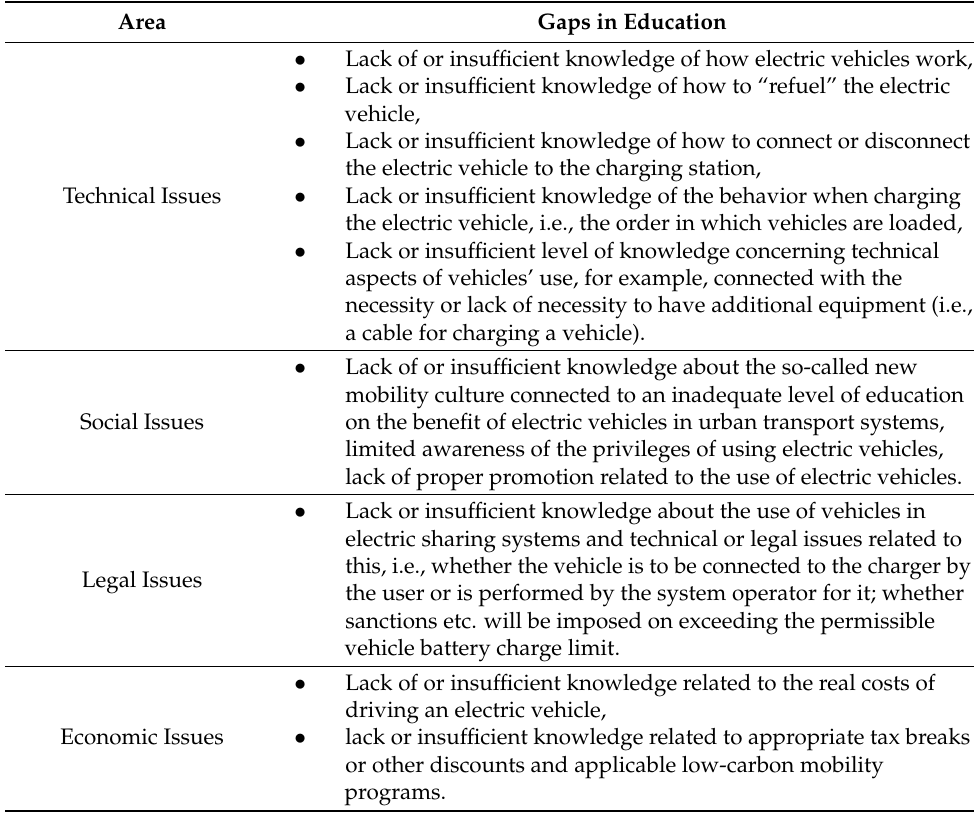
Table 2. Diagnosed deficiencies in education in the field of electric